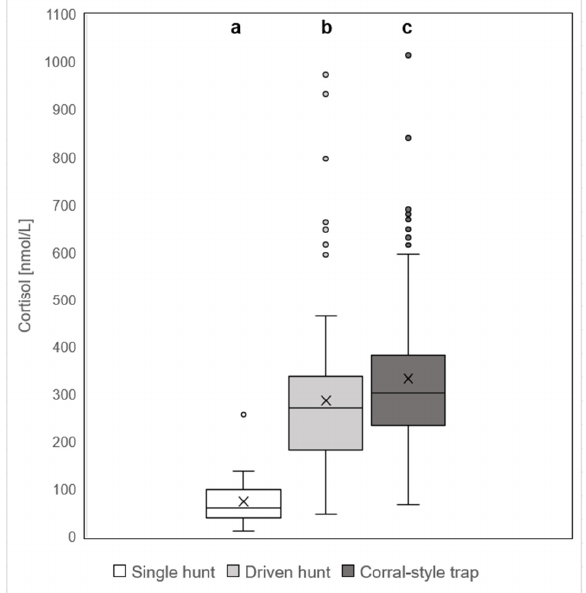
Figure 2. Concentrations of cortisol levels of wild boar shot in single hunts, driven hunts, and trapping. Wild boar caught and shot in corral-style traps ( n = 138) showed higher cortisol levels than wild boar shot during single hunts ( n = 37) and driven hunts ( n = 90). Different superscripts (a, b, c) indicate significant differences in pairwise comparisons ( p < 0.05). Cortisol levels according to the group size (1, 2–4, ≥ 5) of caught wild boar were analysed. Group size had a significant influence on the cortisol level ( F = 20.77, df = 2, p < 0.0001). In the pairwise comparison, cortisol levels of wild boar caught in a group of 5 or more ( Mdn = 272.4 nmol/L, Min = 67.3 nmol/L, Max = 681.1 nmol/L) were significantly lower than in one ( Mdn = 465.5 nmol/L, Min = 382.4 nmol/L, Max = 841.0 nmol/L) or 2–4 ( Mdn = 375.6 nmol/L, Min = 261.9 nmol/L, Max = 1014.6 nmol/L) wild boars per catch after Bonferroni correction (1 vs. ≥ 5 and 2–4 vs. ≥ 5 p < 0.0001; 1 vs. 2–4 p = 0.54; Figure 3).